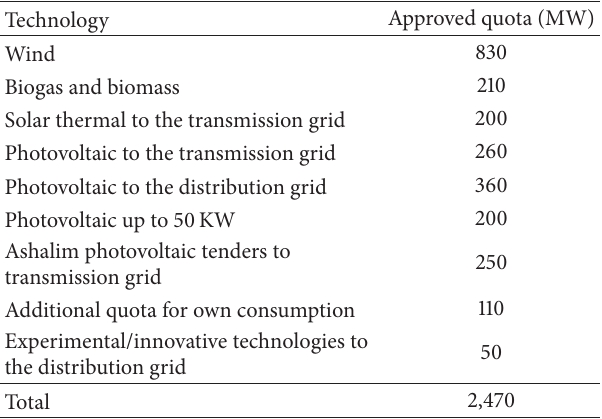
Table 2: Renewable energy sources penetration by